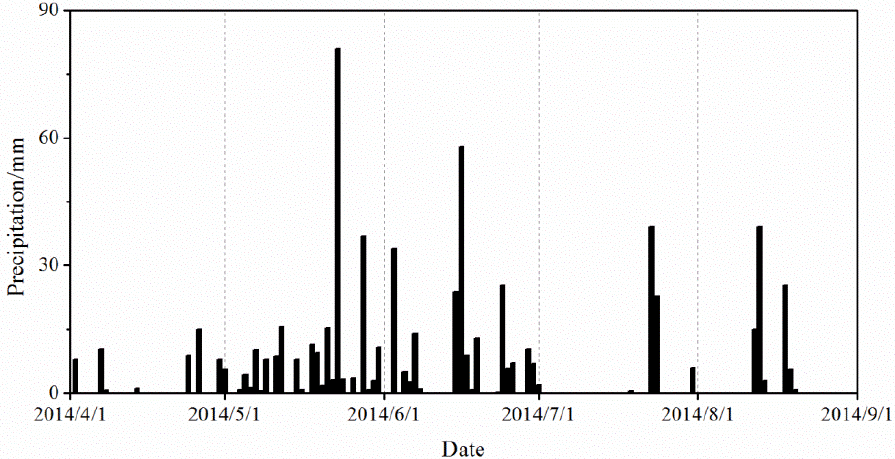
Figure 2. Time series of the daily precipitation in Xiamen Island.